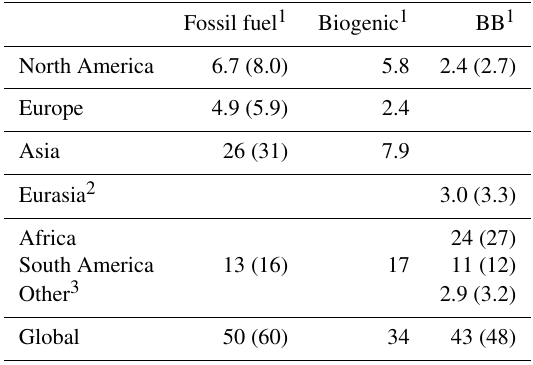
Table 1. Regional August 2016 CO emission totals in the GEOS-5 FP